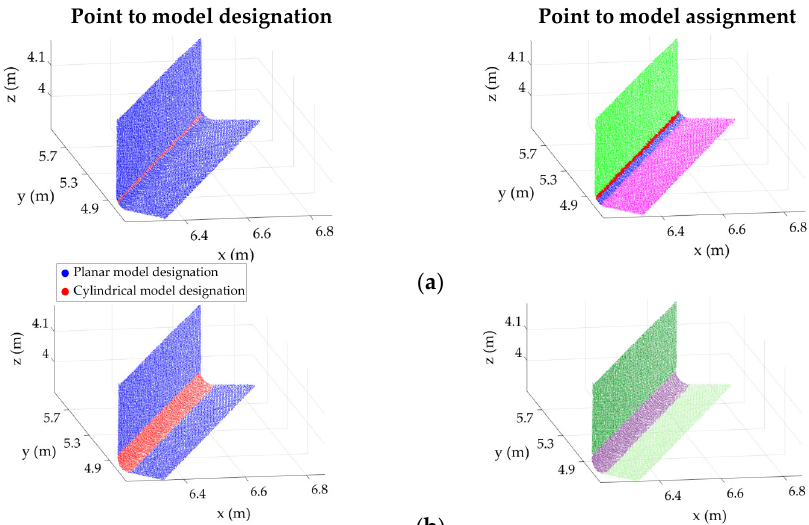
Figure 14. Results of the point-to-model designation (left) and final assignment (right) using ( a ) the random sample and consensus (RANSAC) method of [34] and ( b ) the proposed method (Algorithms 2 and 3).